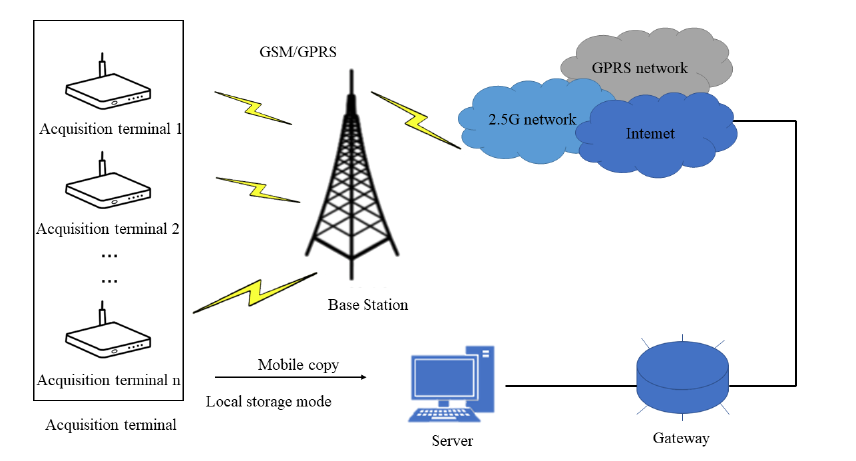
Figure 8. Illustration of wireless collection system for chicken farms.